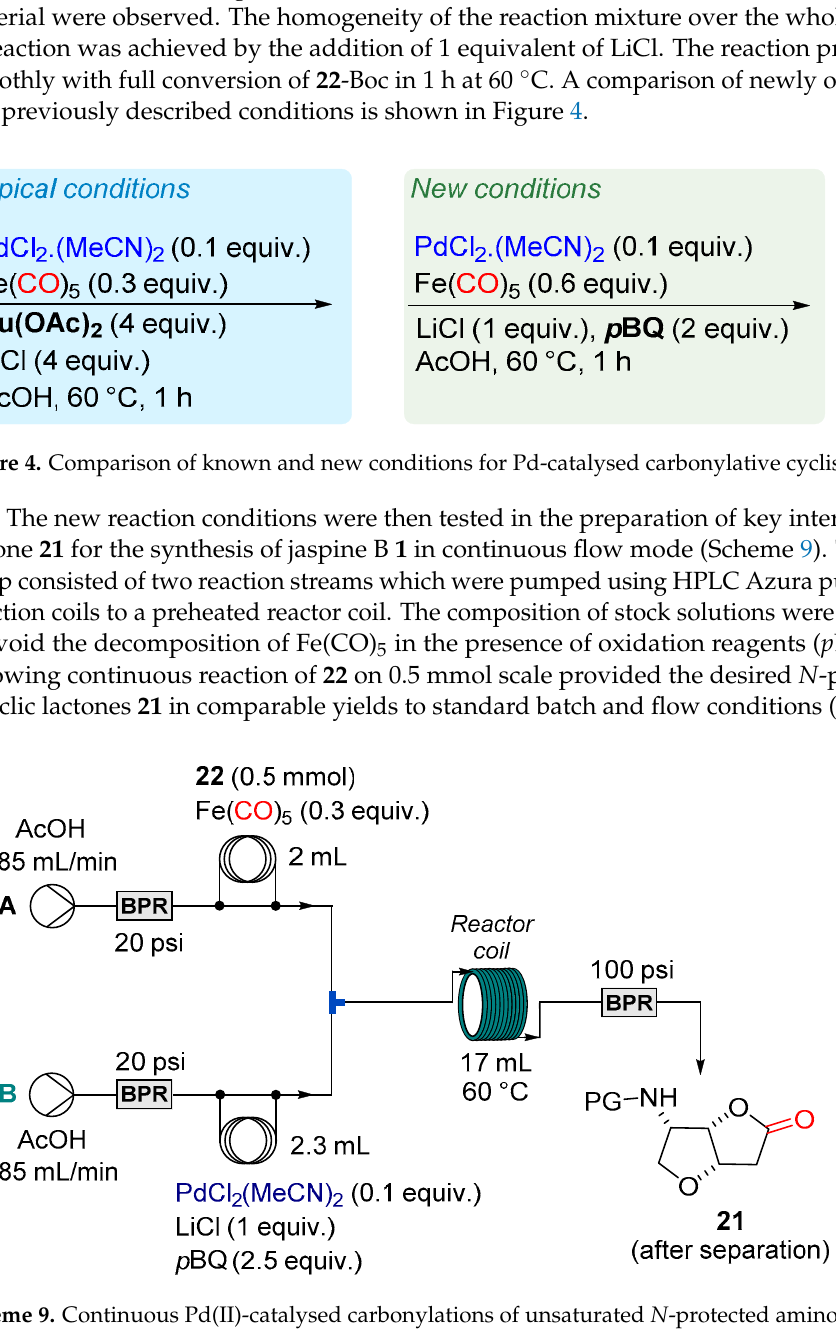
Table 3. Comparison of Pd(II)-catalysed carbonylation of 22 employing batch and flow